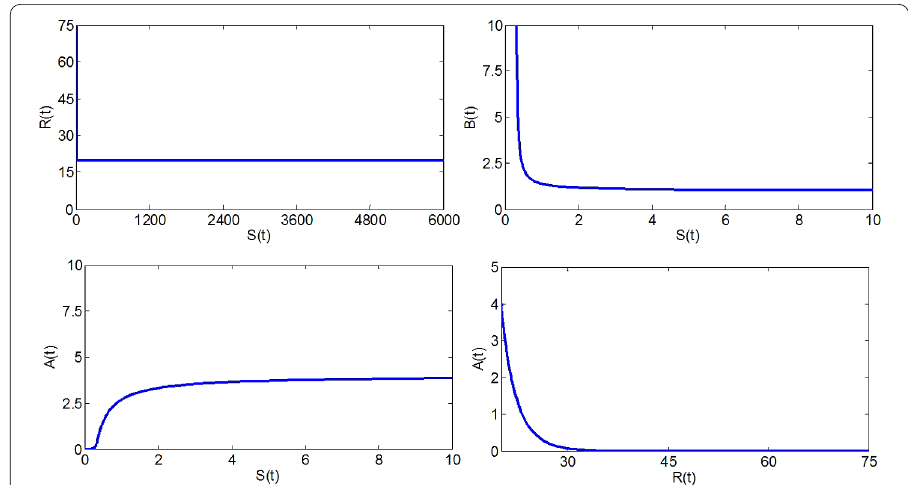
Figure 3 Two-dimensional phase portraits of the deterministic system.